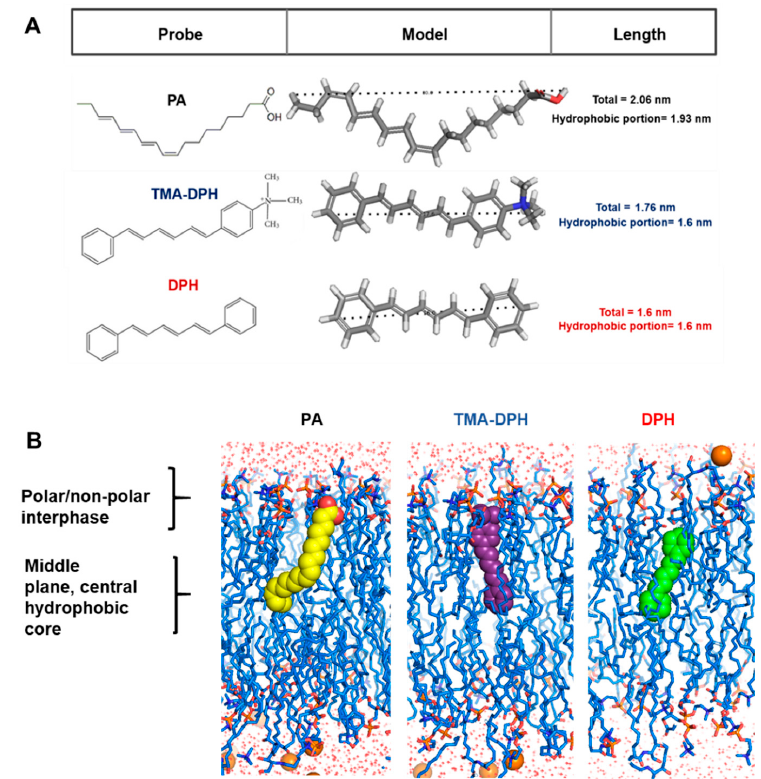
Figure 2. Structural dimensions and membrane localization of the membrane fluorescent probes used in this study. ( A ) Chemical structures and dimensions of the probes. PA is a conjugated polyunsaturated fatty acid that preferentially partitions into liquid disordered domains in membranes and covers the entire length of a fatty acid chain of 18C. TMA-DPH is derived from DPH and contains a cationic trimethylammonium group that functions as an anchor to the membrane surface; it can reach 1.6 nm into one monolayer. DPH inserts into the most hydrophobic portion of a lipid bilayer and has a longitude of 1.6 nm. ( B ) Membrane bilayer (blue) and molecular models of the fluorescent probes inserted are based on molecular dynamics simulations in the